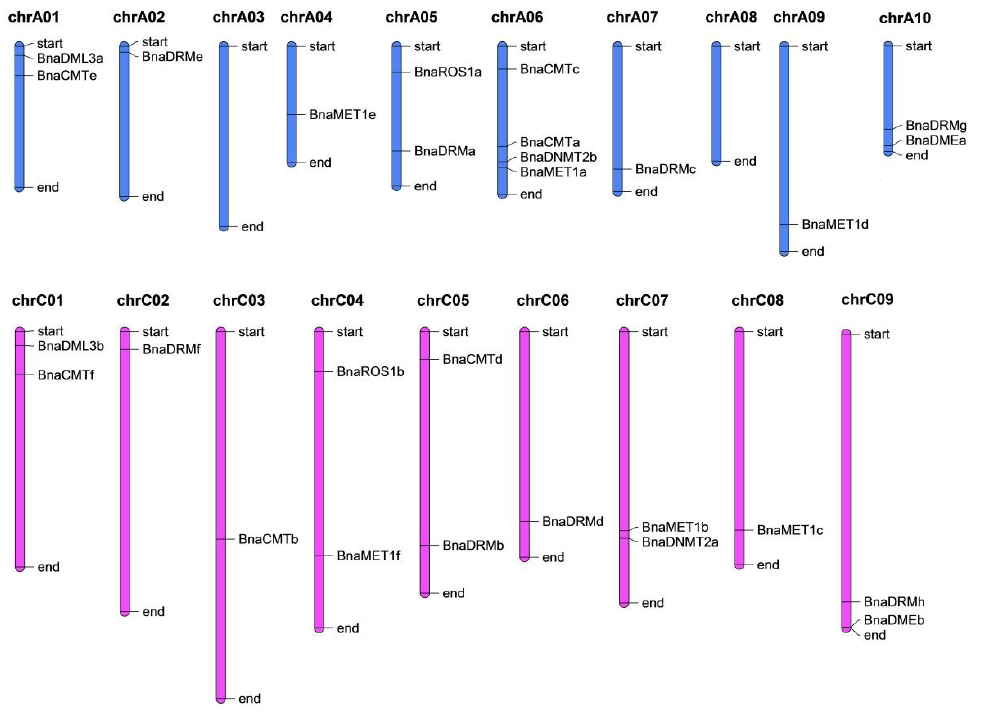
Figure 2. Genomic distribution of rapeseed DNA-MTase and DNA-deMTase families’ genes on chromosomes. The vertical bars with varying lengths represent B. napus chromosomes; short black horizontal lines indicate the position of each gene, chrA01 to chrA10 and chrC01 to chrC09 are the ten and nine chromosomes in the A n and C n subgenomes in B. napus ,